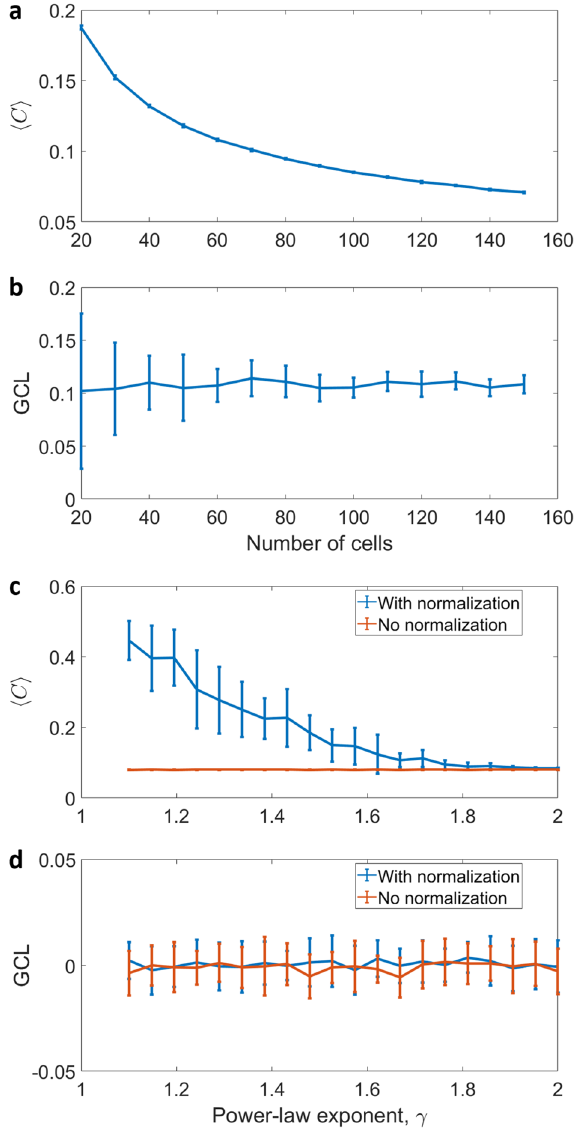
Figure 3. Comparison of the GCL score with the averaged co-expression (cid:31) C (cid:30) . (cid:31) C (cid:30) is defined as the average of the absolute values of Spearman correlations between all the gene pairs, and thus may be used for detecting gene– gene interactions. ( a , b ) Simulated expression profiles ˜ X N × M were created with p = 0.5 and σ = 0 , for different numbers of cells. The GCL measure identifies the coordination between the genes and, in contrast to the (cid:31) C (cid:30) , remains stable even for a small number of cells. ( c , d ) Simulated compositionality in M = 100 expression profiles with different levels of heterogeneity, parameterized by the exponent γ of the power-law distribution. High values of γ correspond with more homogeneous expression profiles, whereas γ → 1 corresponds with high heterogeneity. In this case, since the cell-to-cell variability is generated as independent random variations of the master profile in the different genes (see text), no co-expression and gene-to-gene coordination is expected. For each data point in both figures, we have N = 200 genes with an average of 20 realizations, and every GCL score is calculated for m = 50 different